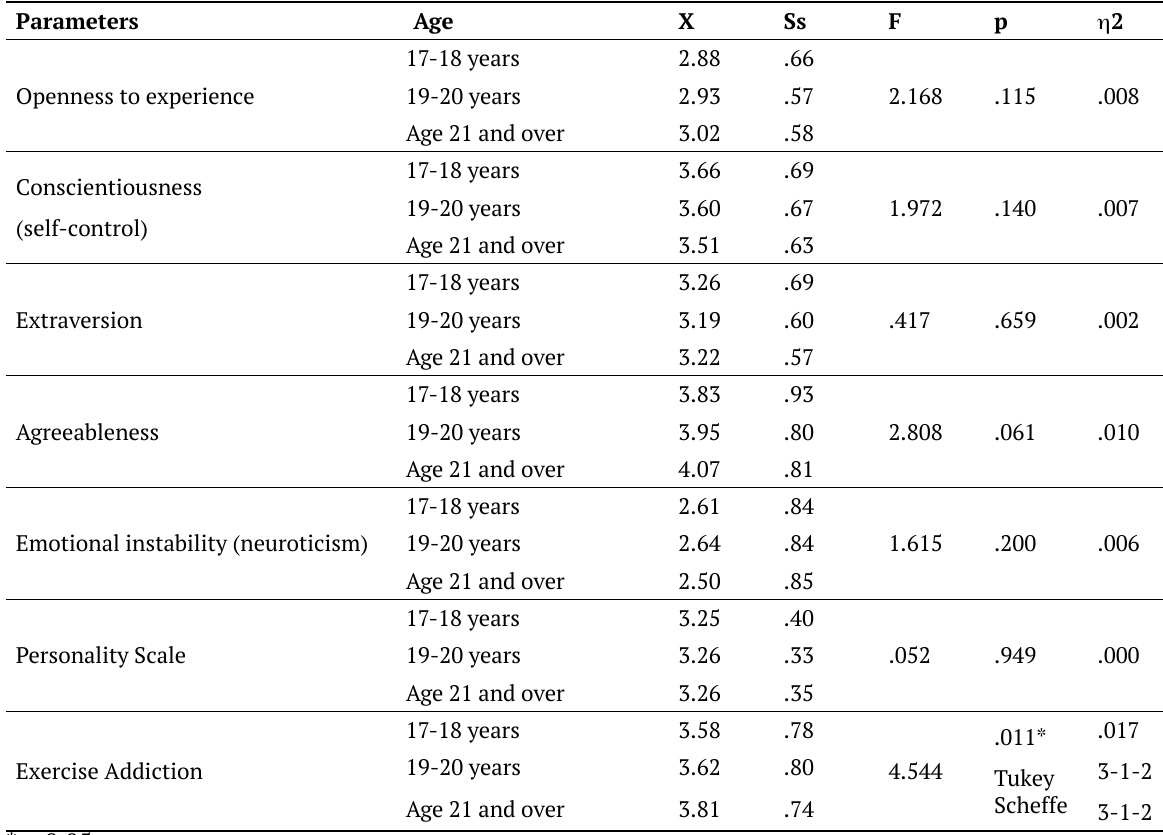
Table 5. Results of exercise addiction and personality ANOVA test depending on students’ age variable Parameters